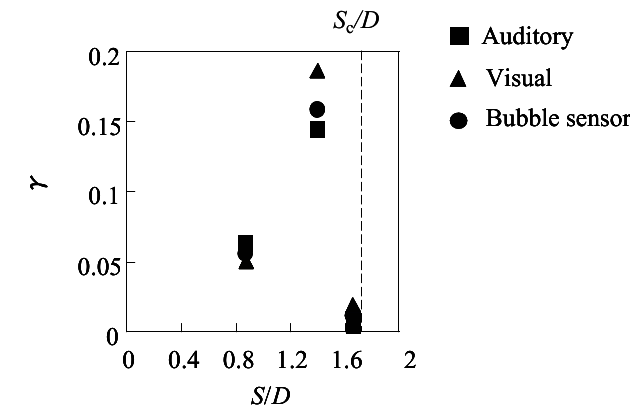
Fig.11 Intermittency factor γ versus S / D （ X / D ＝ 1.32 ） .